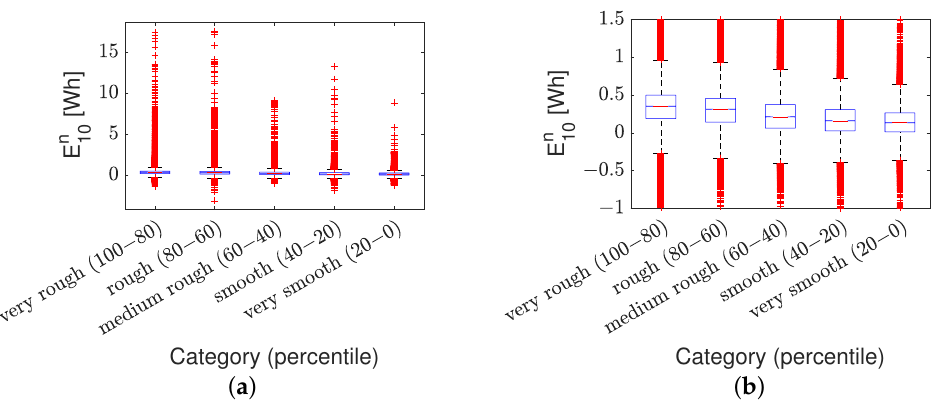
Figure 10. Box-plot of aggregated normalized energy data divided into road roughness categories: ( a ) energy data for group no. 1 and ( b ) close-up of the same data.